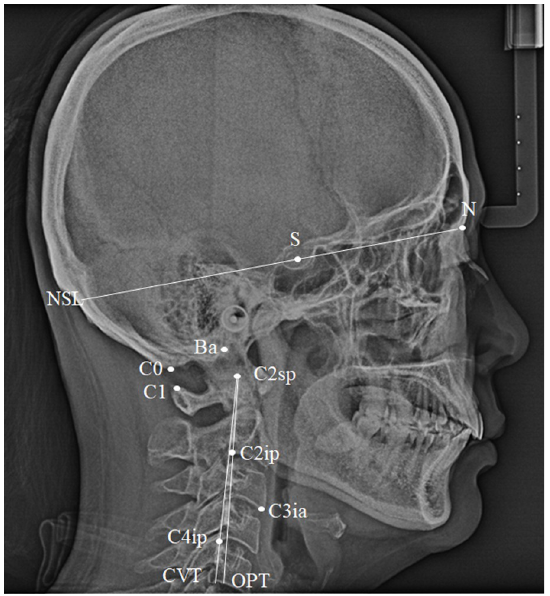
Fig 1. Cephalometric landmarks and variables used for analysis of the head and neck posture. Ba, basion; N. nasion; S, sella; C0. Base of the occiput; C1, the posterior arch of the atlas; C2, the spinous process of the second vertebra; C2sp, the most superior-posterior point on the body of the second vertebra; C2ip, the most inferior-posterior point on the body of the second vertebra; C3ia, the most inferior-anterior point on the body of the third vertebra; C4ip, the most inferior-posterior point on the body of the fourth vertebra; OPT, posterior tangent to the odontoid process through C2ip; CVT, posterior tangent to the odontoid process through inferior C4ip.